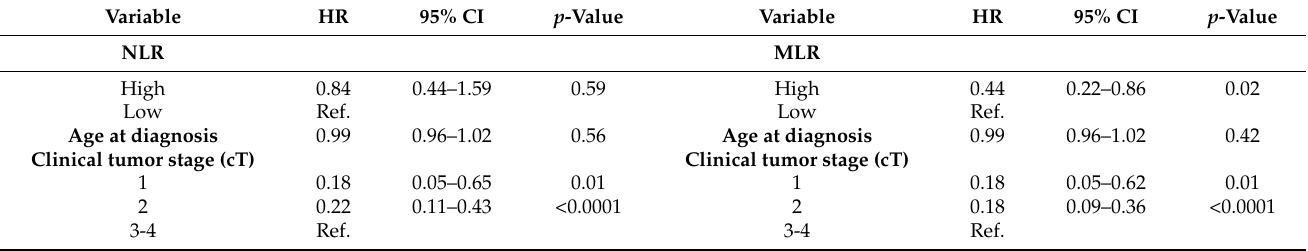
Table 4. Multivariate analyses of inflammatory and clinical characteristics in relation to 5-year DMFS in the study population (n =